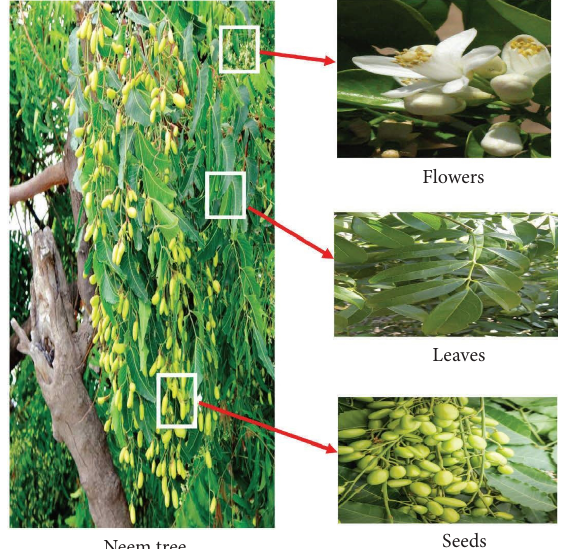
Figure 3: Te whole tree of neem with indicated individual